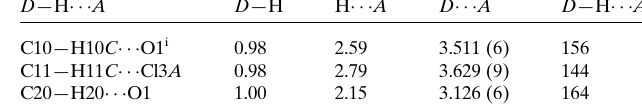
Table 2 Hydrogen-bond geometry (A˚ , (cid:3) ) for II (cid:2) CHCl 3 . D —H (cid:2)(cid:2)(cid:2) A